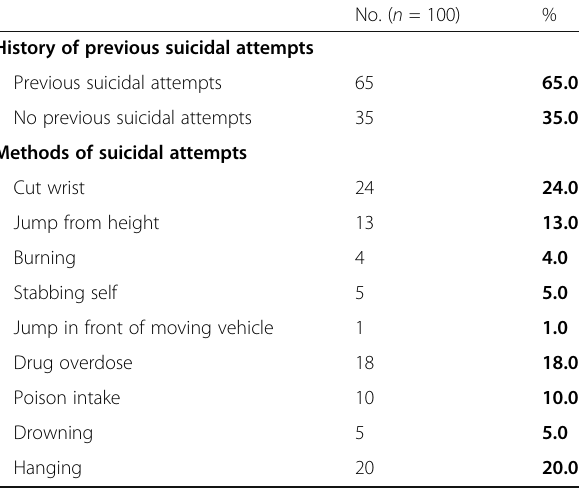
Table 3 History of previous suicidal attempts and methods used among patients in the studied sample